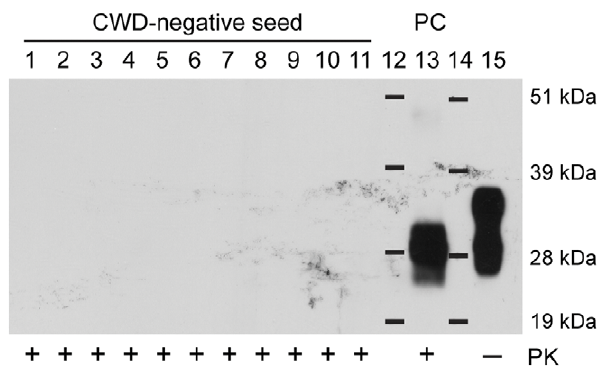
Figure 4. Serial PMCAb has high specificity. Eleven 10 m L CWD- negative white-tailed deer, homozygous for the wild-type Prnp , gene brain homogenate (BH; 10% w/v) samples (lanes 1–11) or 10 m L 3.2 6 10 2 12 dilution of wt/wt CWD + white-tailed deer BH (lane 13) was added to 90 m L NBH with 0.05% saponin and subjected to six successive rounds of 96-cycle PMCAb. Samples from the sixth round were digested with proteinase K (PK; 50 m g ? mL 2 1 final concentration) for 1 h at 37 u C except one no-PK control.